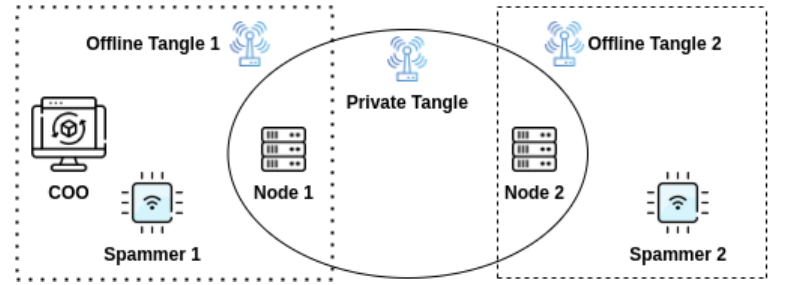
Figure 7. Experimental setup of IOTA